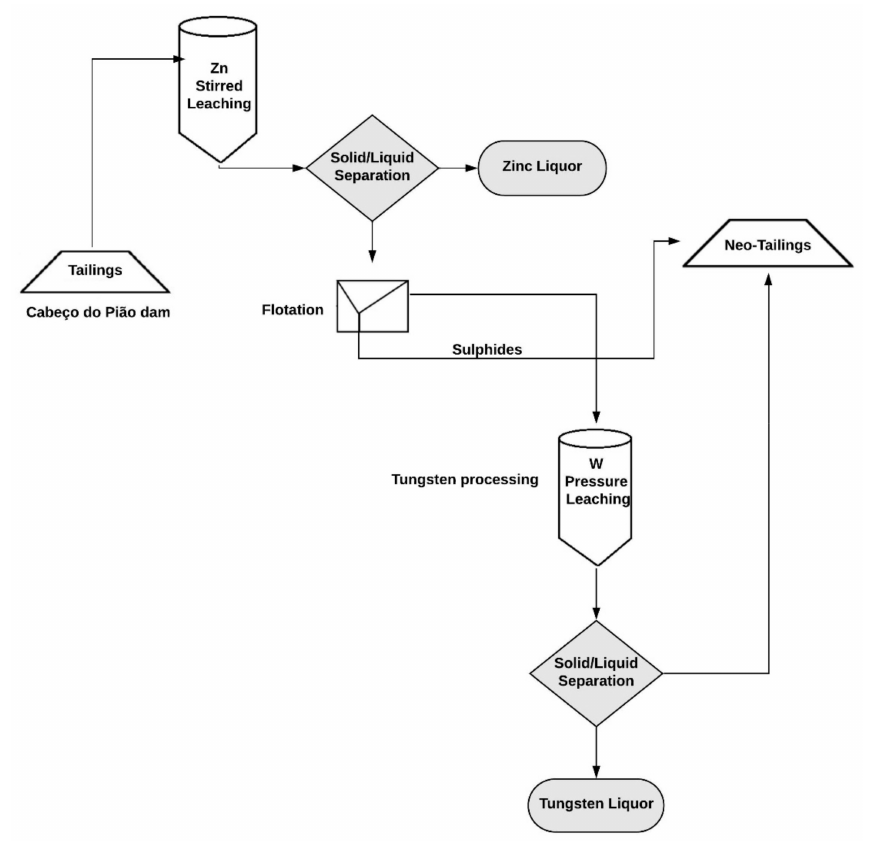
Figure 2. Simplified reprocessing flowsheet proposed for the re-mining project of Cabeço do Pi ã